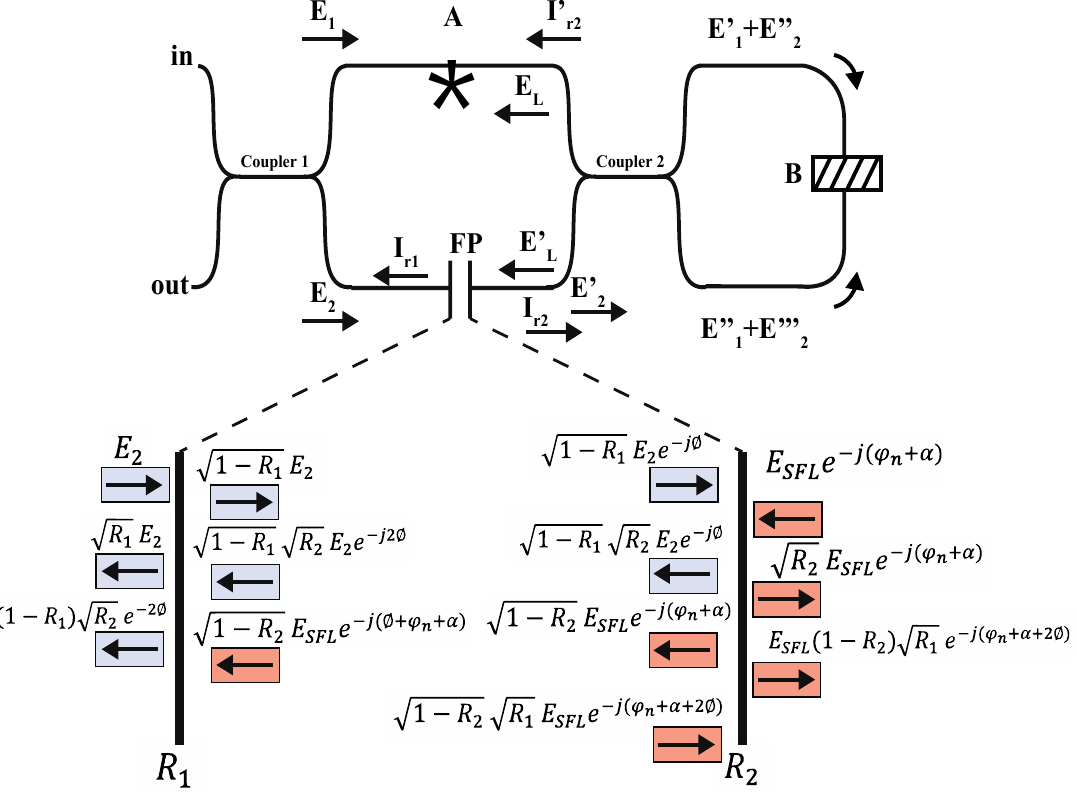
Figure 2. Fiber optic arrangement sketch and its optical path analysis. The mechanical coupler is represented by A , and B represents the cuvette holder with the milk samples. Inset: Fabry–Perot dual response analysis.